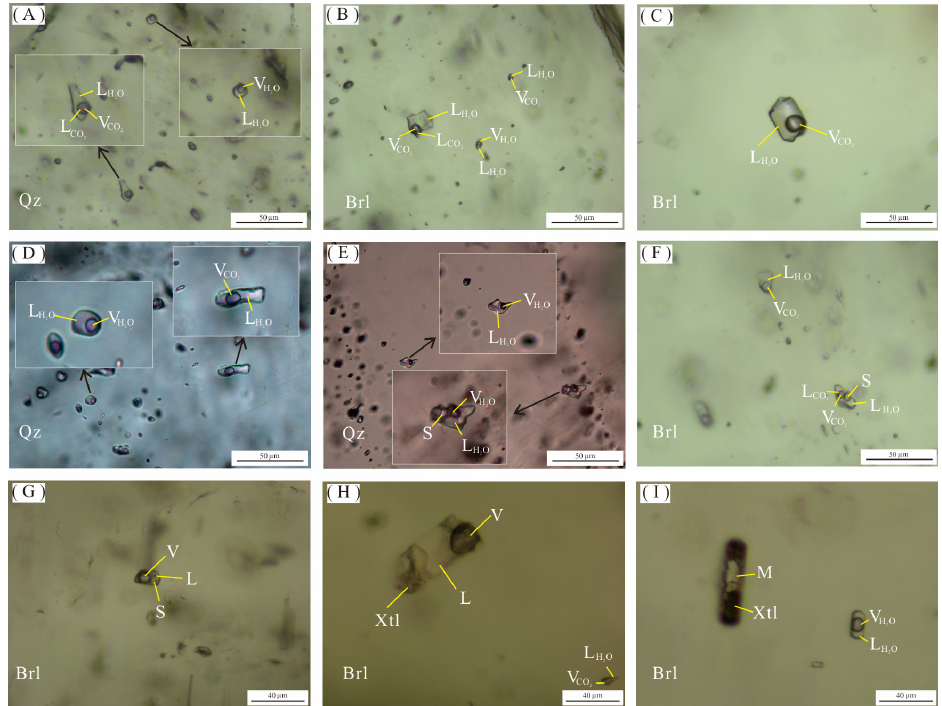
Figure 6. Microscopic photos of fluid and melt inclusions of the Dakalasu No. 1 pegmatite vein. ( A , B ) Three-phase CO 2 inclusions and two-phase gas-liquid inclusions in quartz and beryl; ( C ) CO 2 - bearing two-phase aqueous inclusions in beryl; ( D ) Gas-liquid two-phase inclusions in quartz and CO 2 -bearing two-phase aqueous inclusions; ( E – G ) Daughter mineral-bearing inclusions and gas- liquid two-phase inclusions in quartz and beryl; ( H ) Fluid-melt inclusions coexist with CO 2 -bearing two-phase aqueous inclusions in beryl; ( I ) Crystalline silicate melt inclusions coexist with gas-liquid two-phase inclusions in beryl.